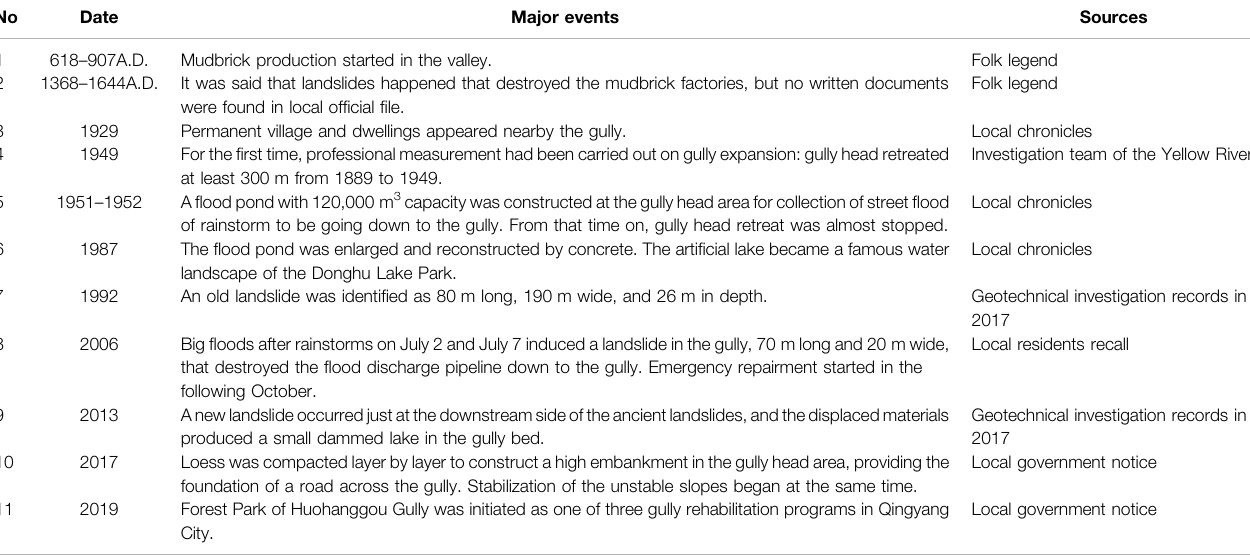
TABLE 4 | Major hazardous events and rehabilitation of the Huohanggou